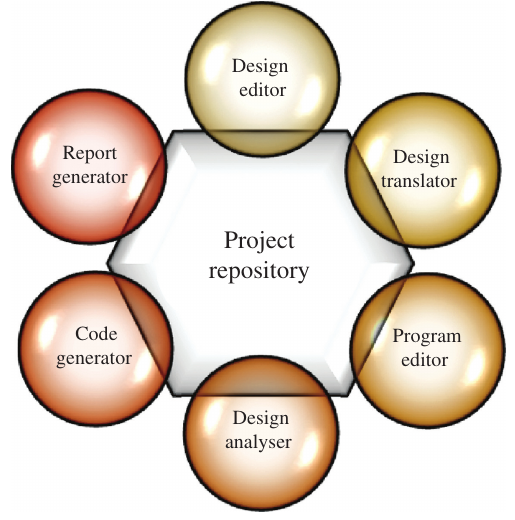
Figure 1: Architecture of CASE Software